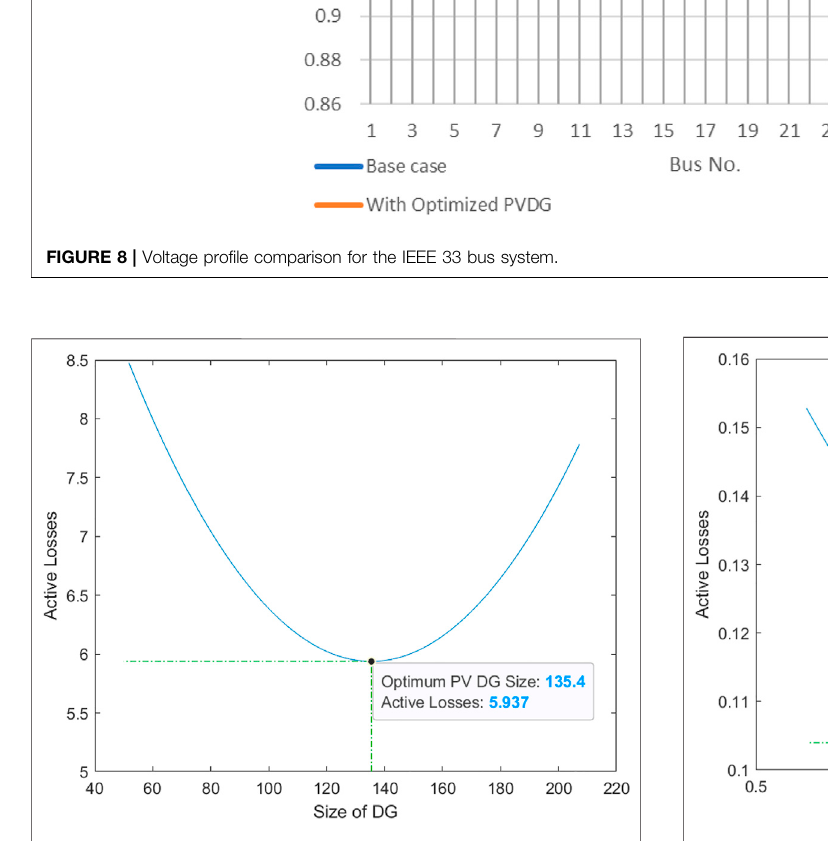
FIGURE 9 | Active loss characteristics with PV-DG size variation. FIGURE 10 | Active loss characteristics with PV-DG size